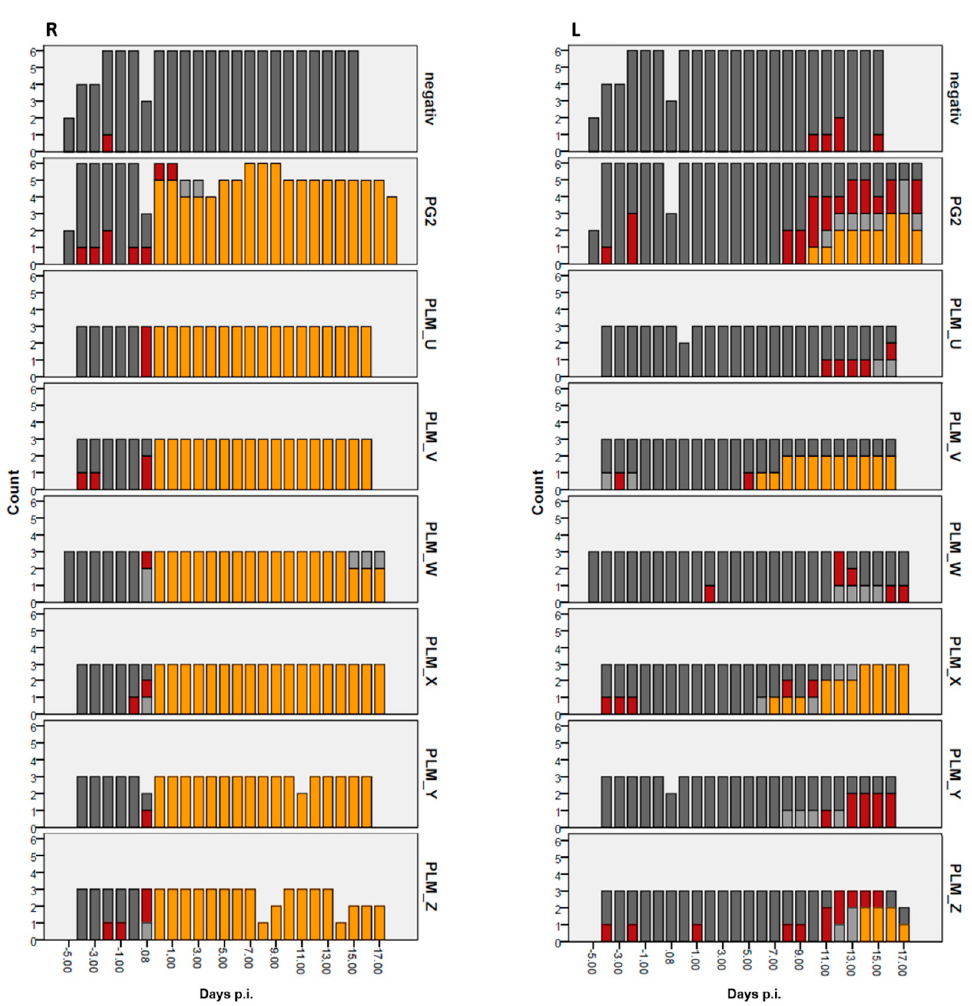
Figure 4. Graphic representation of the California Mastitis Test (CMT) scores of the infected sheep groups and the negative control group. The right panel denotes milk from the left udder halves ( L ) and the left one denotes milk from right udder halves ( R ). Assessment was primarily made according to Table 4 to demonstrate the degree of gel formation: dark grey [ − /(+)], red [+], light grey [++], yellow [+++].